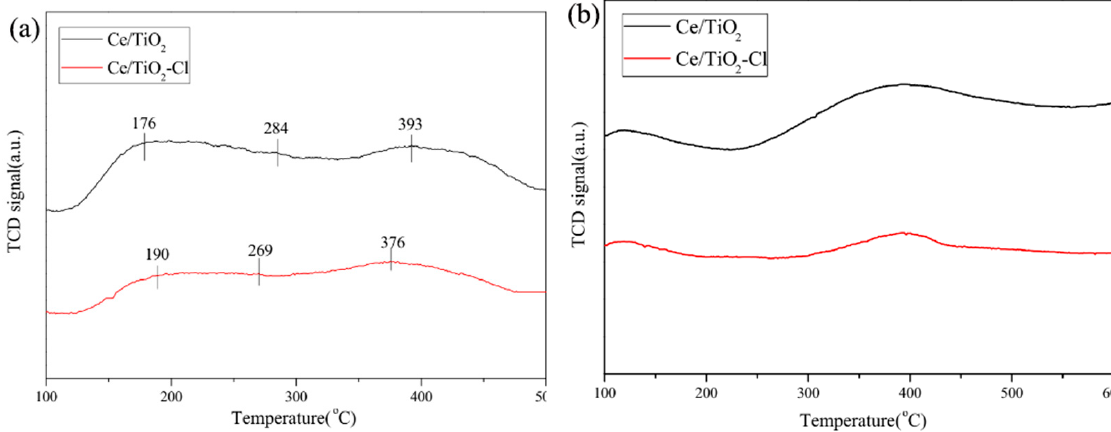
Figure 22. ( a ) NH 3 -TPD profiles of the two catalyst samples, ( b ) NO-TPD profiles of the two catalyst samples [89].